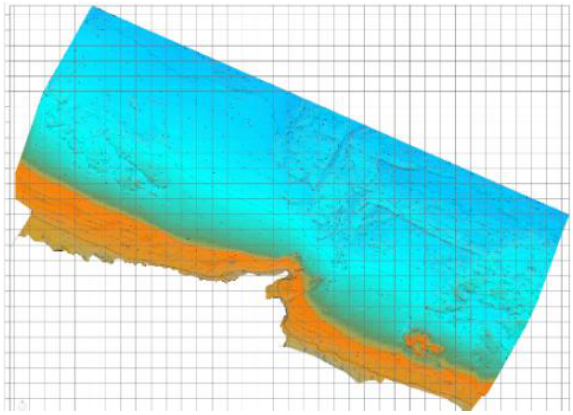
Figure 7. Results of bathymetric